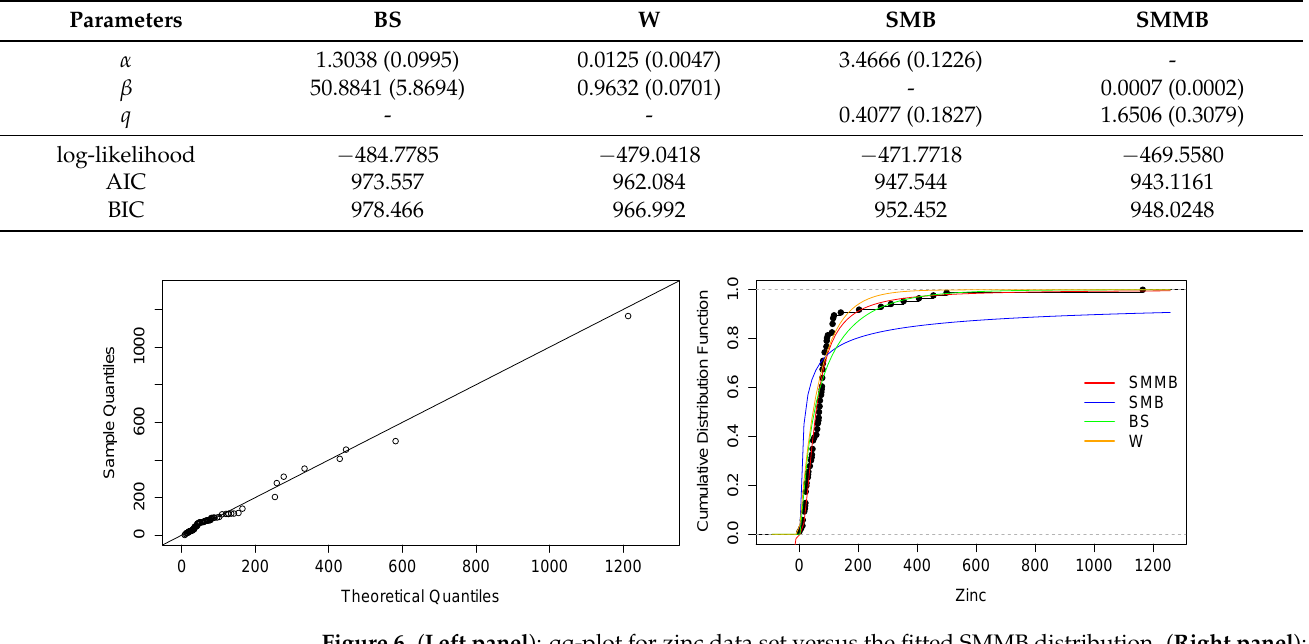
Table 4. Estimates, SE in parenthesis, log-likelihood, AIC and BIC values for zinc concentration data.